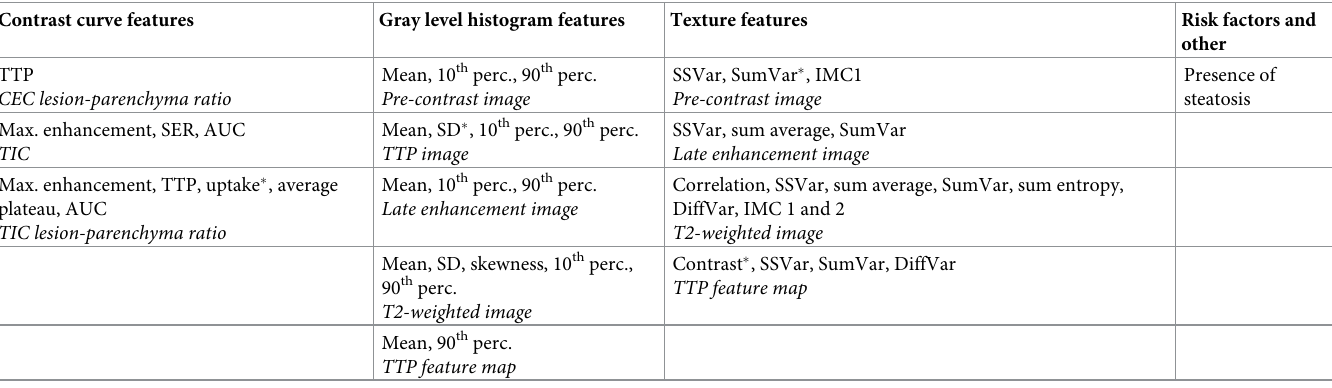
Table 3. Selected features with the highest ANOVA